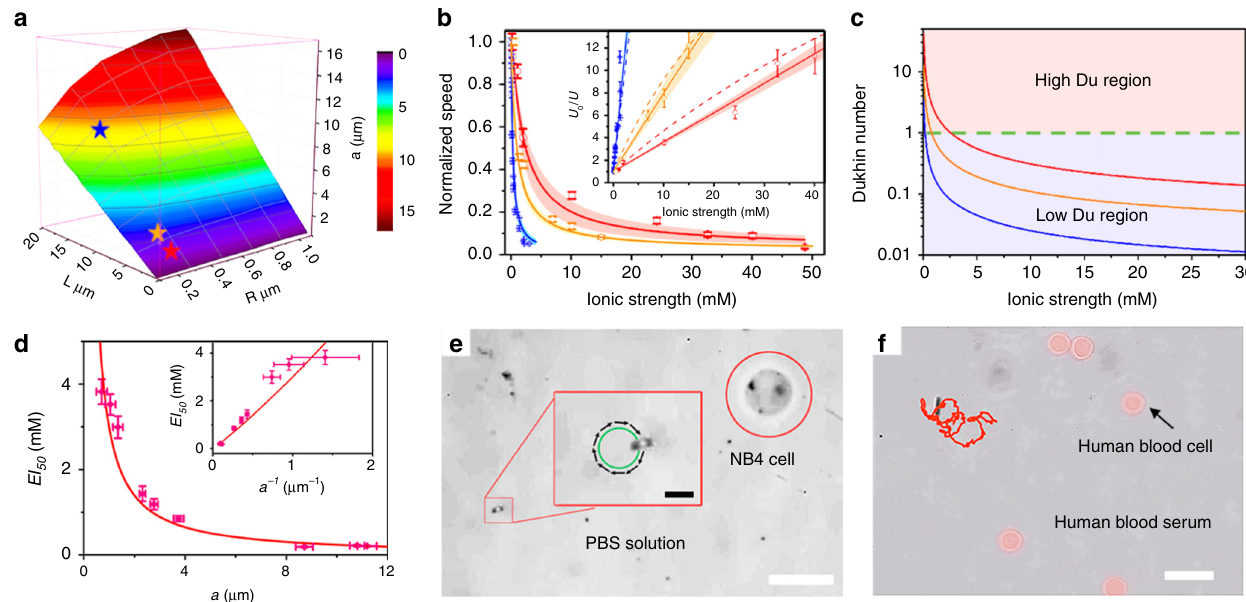
Fig. 5 Geometry optimization biocompatibility demonstration with the live human cell (acute promyelocytic leukemia NB4 and human blood cells). a The dependence of the geometry factor “ a ” on nanowire ’ s geometry. The three nanowire geometries in b are marked as the red star (short nanowire), orange star (medium nanowire), and blue star (long nanowire) respectively. b The representative ionic strength dependence of the normalized speed of the SPS coated nanowire microswimmer for short (red), medium (orange), and long (blue) nanowire microswimmers. The corresponding absolute velocity data is shown in Supplementary Fig. 13. The solid lines are calculated by Eq. (2) with measured SPS conductivity and the bands are the con fi dence interval at 95% con fi dence. The inset shows the linear relationship of the normalized reciprocal speed with the ionic strength. The dash lines are the expected relationships predicted by Eq. (2). The solid lines and corresponding color bands in the inset indicate the fi tting plots with the con fi dence interval of the experimental data at 95% con fi dence level. c The Dukhin number to the ionic strength dependence for the SPS-coated microswimmers with different geometries. The red, orange, and blue curves are corresponding to the Du of the short, medium, and long nanowire with a = 0.74, 2.32, and 9.16 μ m, respectively. d The relationship between EI 50 and geometric factor “ a ” . The dots correspond to data from Table S5. The red line shows the theoretical curve based on Eq. (3). The inset shows the corresponding linear relationship between EI 50 and a − 1 . The error bar of “ a ” and a − 1 re fl ects the size uncertainty obtained from the swimmers ’ tracking videos; see details in Supplementary Note 15. e Demonstration of microswimmer operation in PBS buffer solution together with the live NB4 cell (scale bar is 20 μ m). The inset shows the magni fi ed view of the microswimmer with the trajectory of 2 s (scale bar of the inset is 5 μ m). f The trajectory of the microswimmer operation in diluted human blood (scale bar is 10 μ